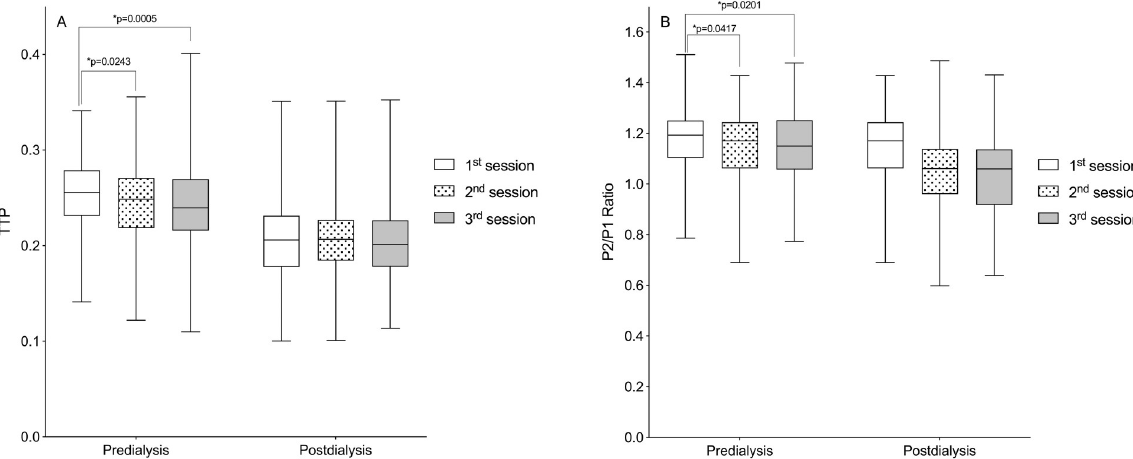
Fig 3. Comparison of predialysis and postdialysis noninvasive intracranial pressure (ICP) parameters according to the hemodialysis sessions over the six months of follow-up. (A) Time to peak (TTP). (B) P2/P1 ratio. Box-plots illustrate the median and interquartile range of the noninvasive intracranial pressure parameters at the three weekly hemodialysis sessions (1 st , 2 nd , and 3 rd ) over the six months of follow-up ( � p < 0.05, repeated-measures ANOVA followed by the Tukey’s post-hoc test).